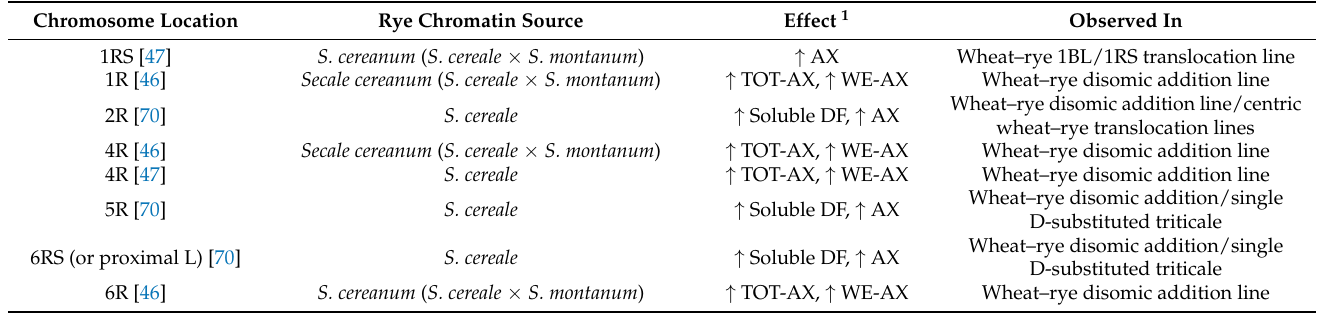
Table 1. List of genomic regions regulating arabinoxylan content in rye that were determined by the characterisation of wheat–rye translocation and addition lines. Chromosome 1R of Secale cereanum is suggested to be the product of a translocation between S. cereale —acting as short arm